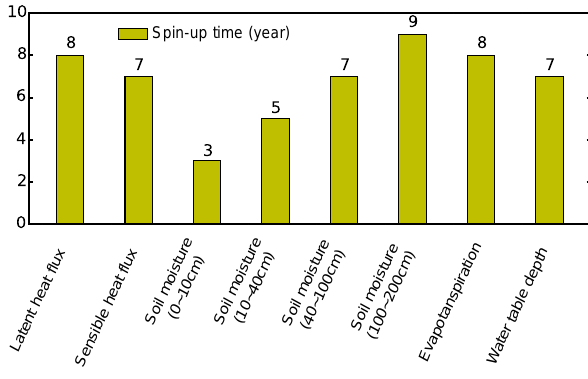
Figure 3. Averaged spin-up time (in years) for individual